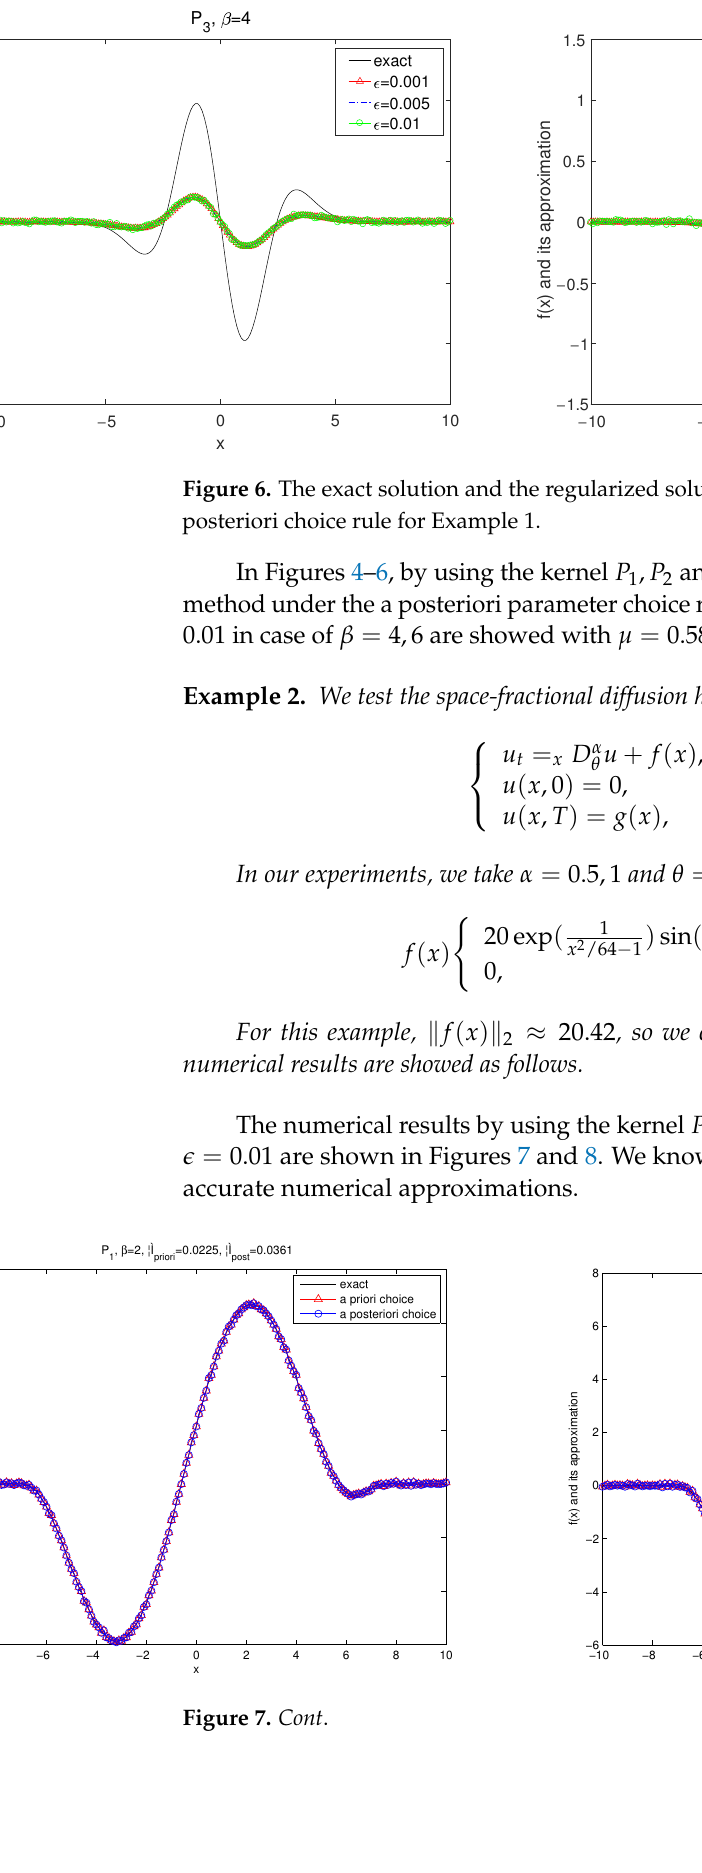
Figure 7: The exact solution and the regularized solutions of Example 2 for α = 0 . 5 under the a-priori parameter choice and the a-posteriori parameter choice. 16